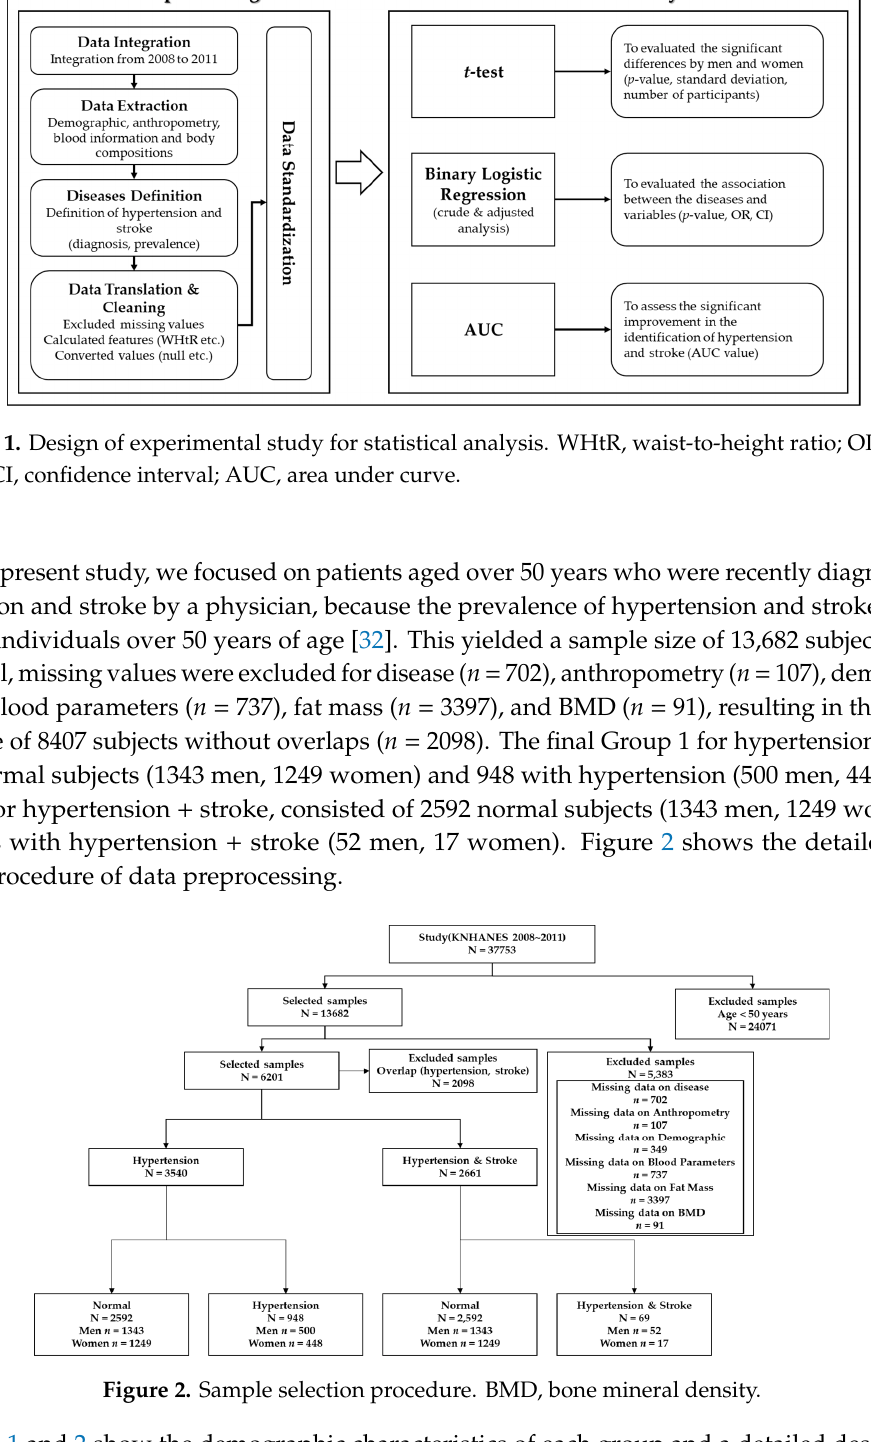
Figure 2. Sample selection procedure. BMD, bone mineral density.